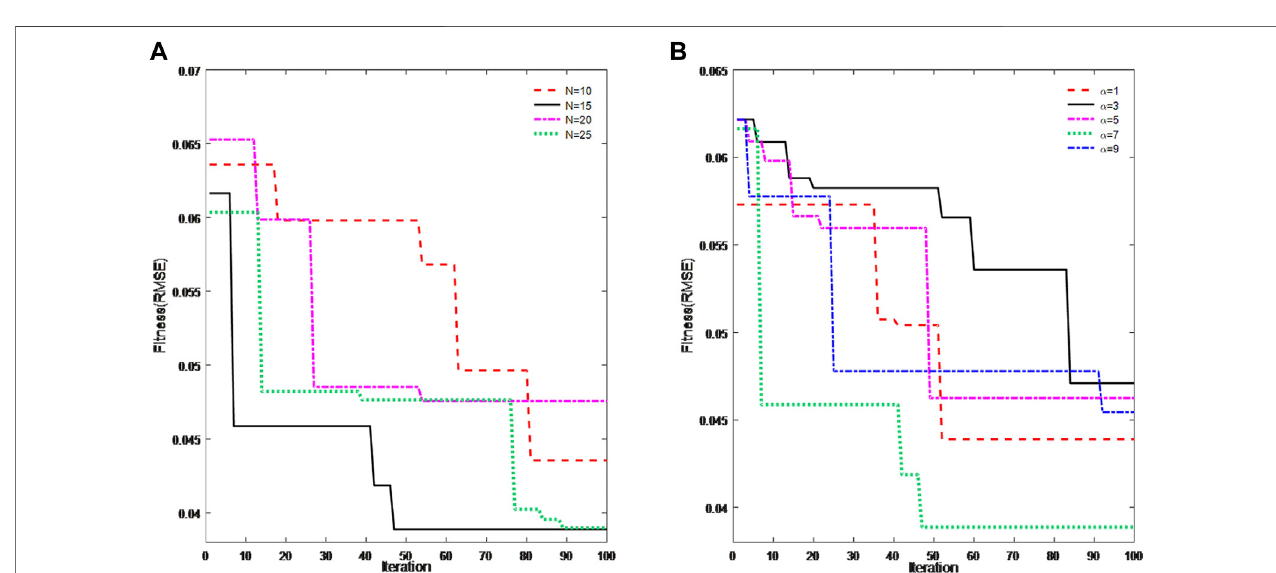
FIGURE 4 | Fitness of variation with the increase of iterations: (A) α (cid:2) 7; (B) N = 15.